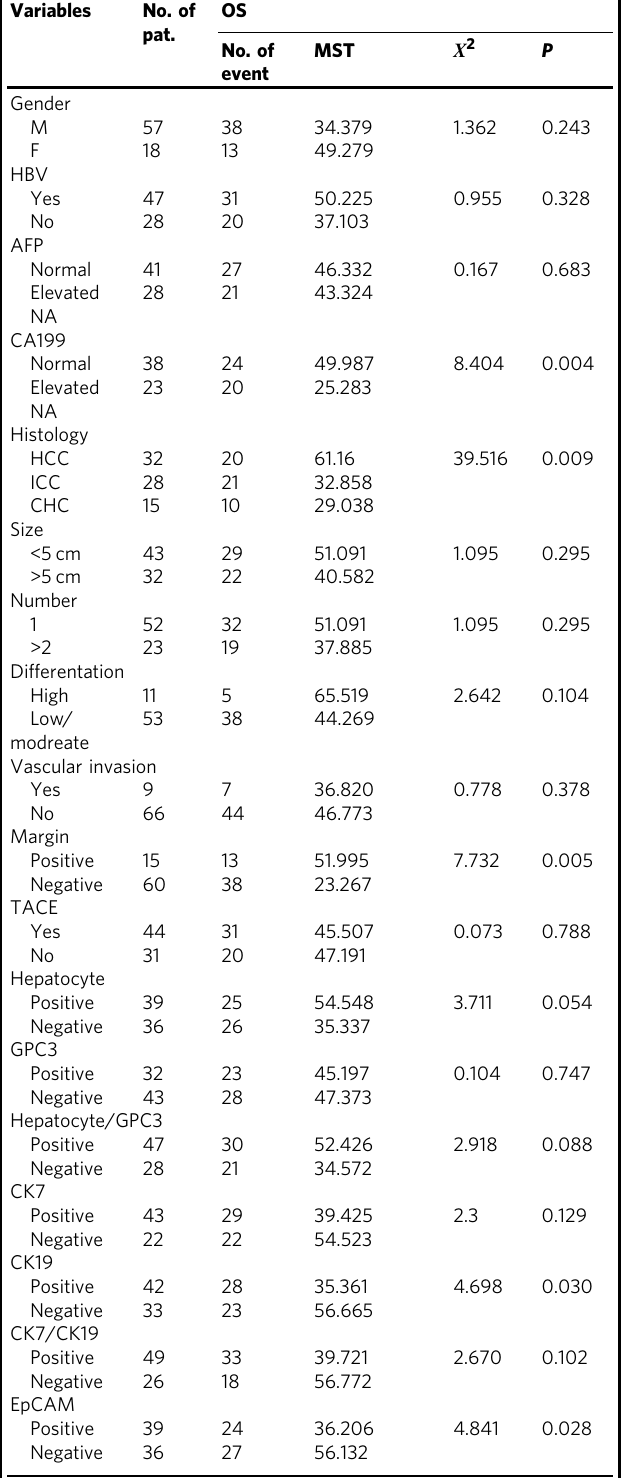
Table 1 Results of univariate analyses in liver cancer Variables No. of pat.